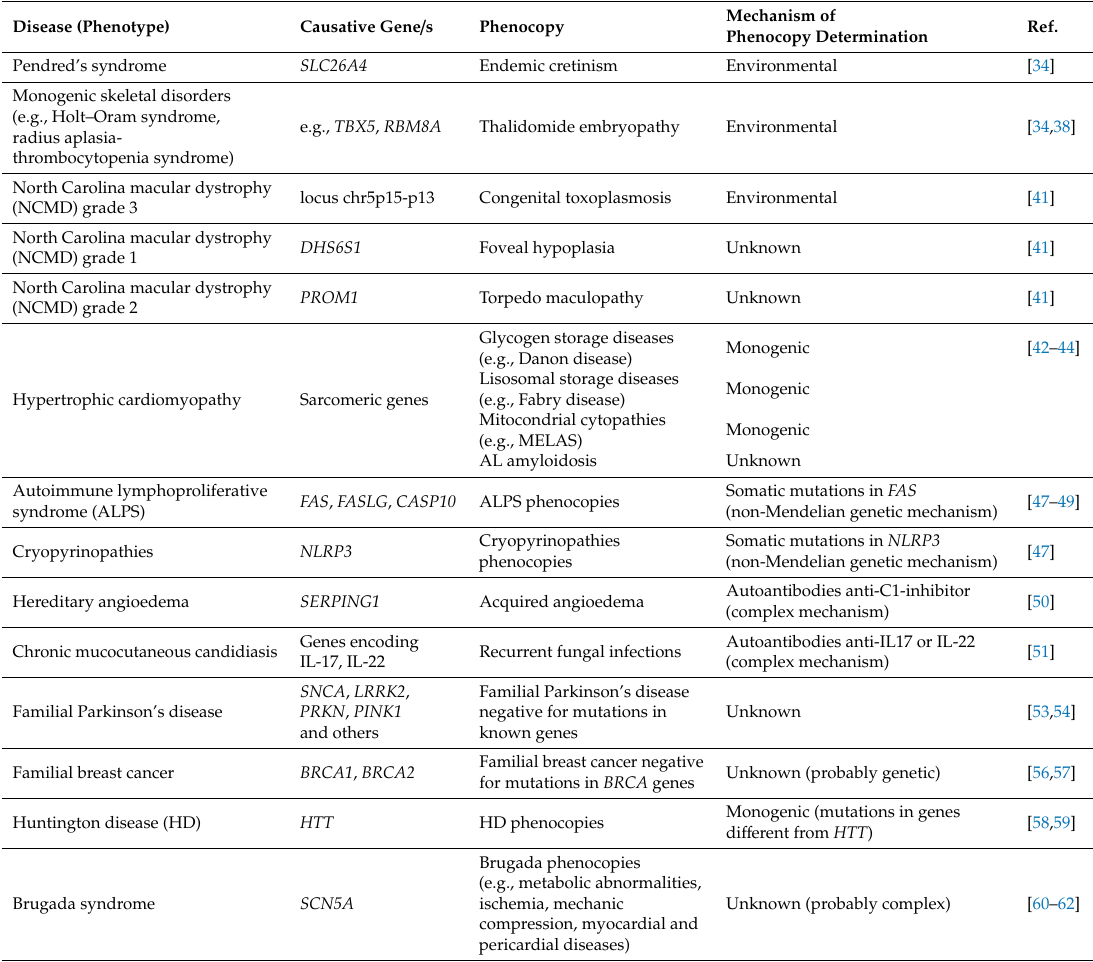
Table 1. Examples of phenocopies in human diseases. This is a table illustrating examples of phenocopies in di ff erent fields of medicine. For each disease, we report disease-causing genes (when known), phenocopies and corresponding